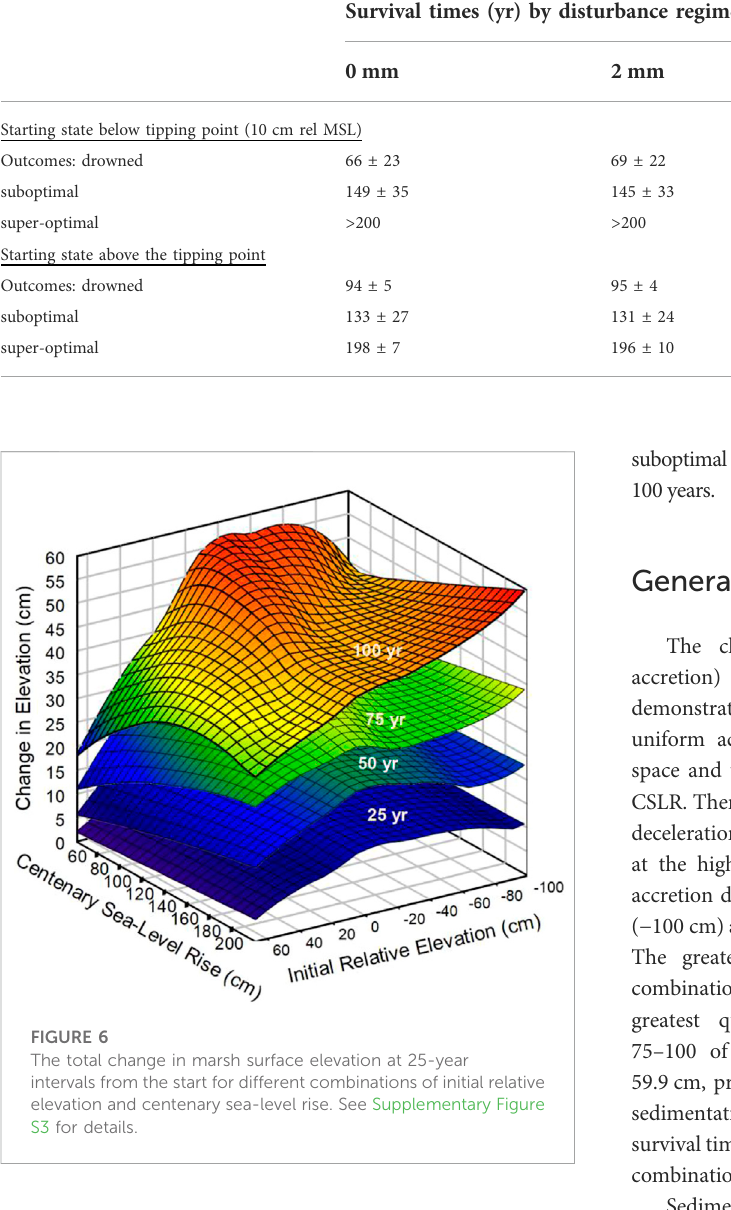
TABLE 4 Mean survival times (±1 SD) as functions of episodic disturbance regime and starting elevation. Outcomes were classi fi ed into three categories — drowned, suboptimal, and super-optimal elevation. Starting elevations were classi fi ed as either suboptimal (-97 to 10 cm) or super- optimal (10 – 60 cm). The survival times are shown as functions of amounts of episodic sediment deposits occurring triennially and were generated from model permutations of starting elevation in 5 cm increments and CSLR (from 40 to 200 cm per 100 years) in 10 cm increments.